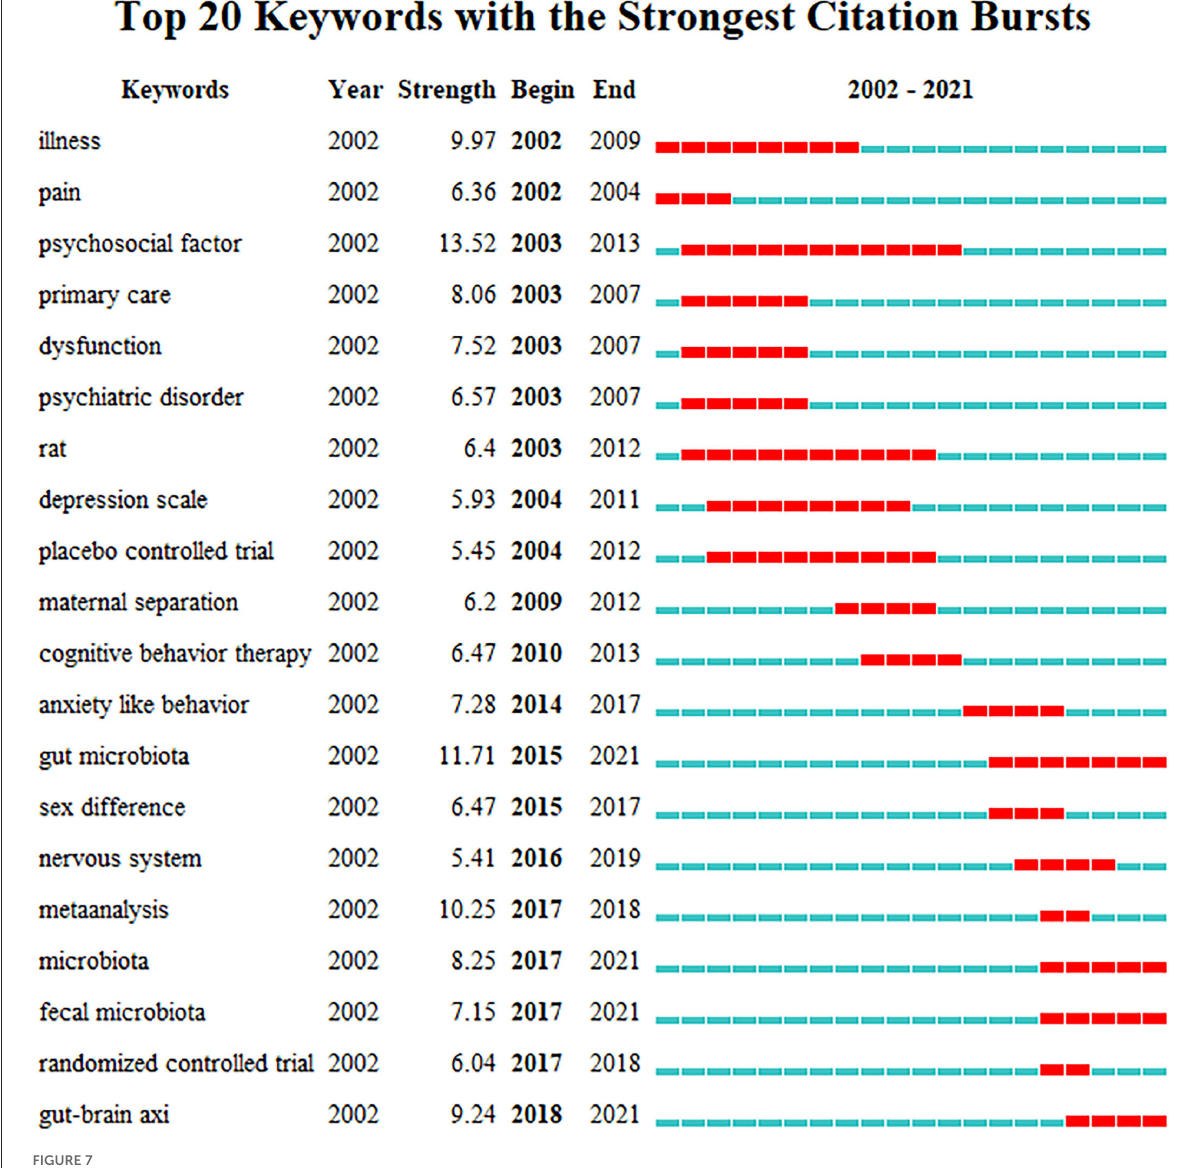
FIGURE7 Top 20 keywords with strongest strength of